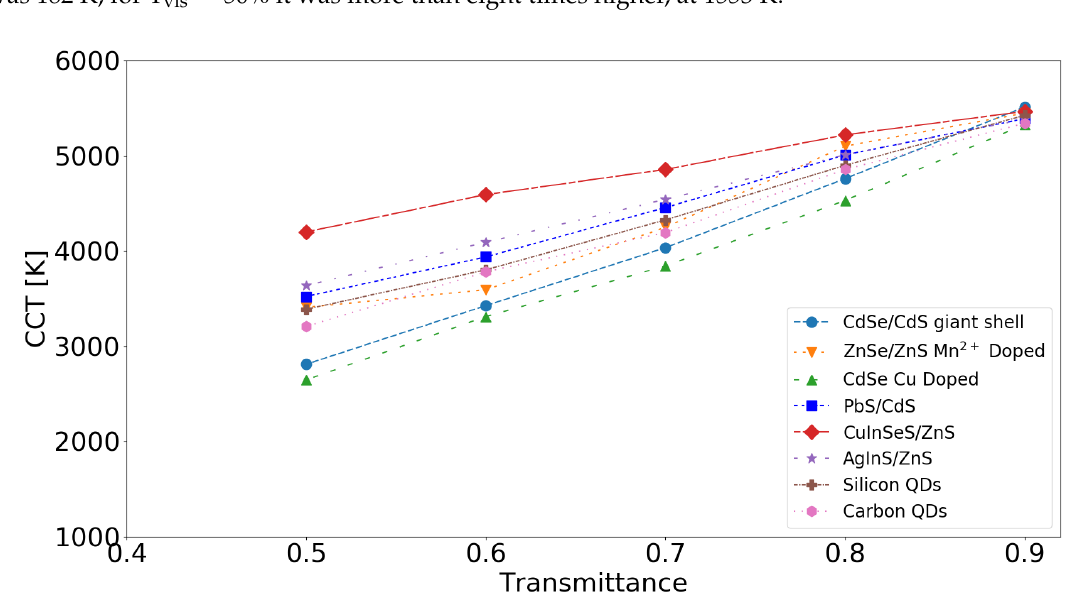
Figure 10. Correlated color temperature (CCT) in Kelvin, plotted against T vis